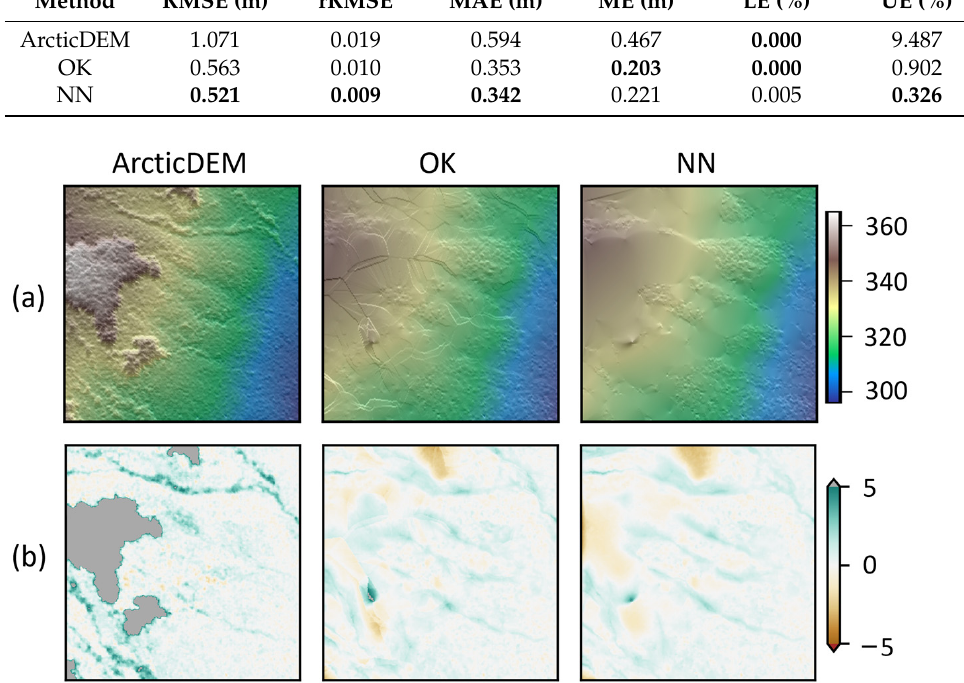
Figure 7. ArcticDEM and DTM interpolation at Site-1: ( a ) ArcticDEM, DTMs predicted by OK and NN spatial interpolation techniques, and ( b ) elevation difference maps between ArcticDEM, the predicted DTMs and the reference lidar-derived DTMs.